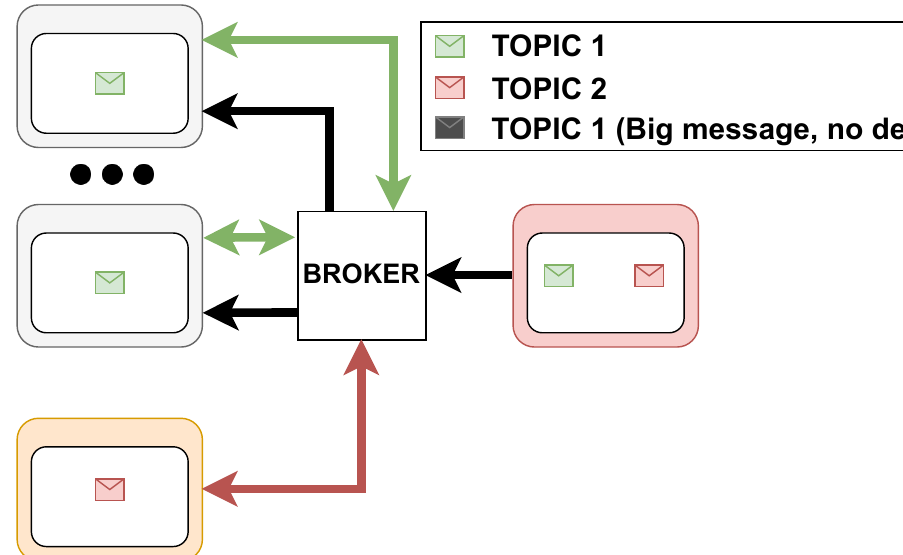
Figure 18. MQTT-SN congested accumulated traffic scheme.